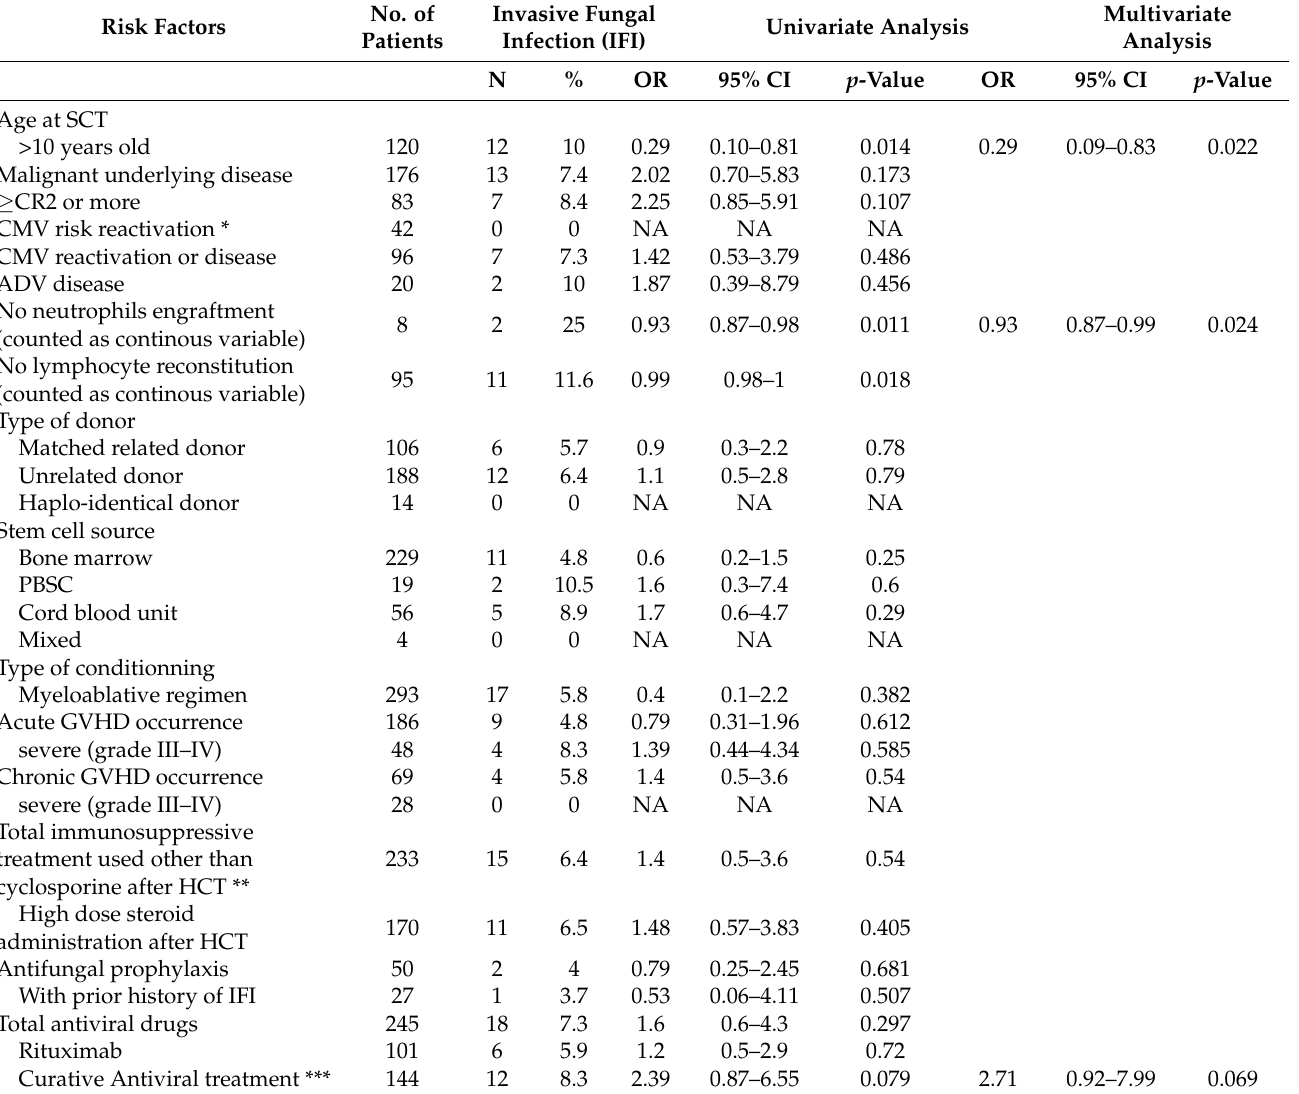
Table 4. Possible risk factors for the occurrence of IFI after pediatric allogenic HCT after one year of